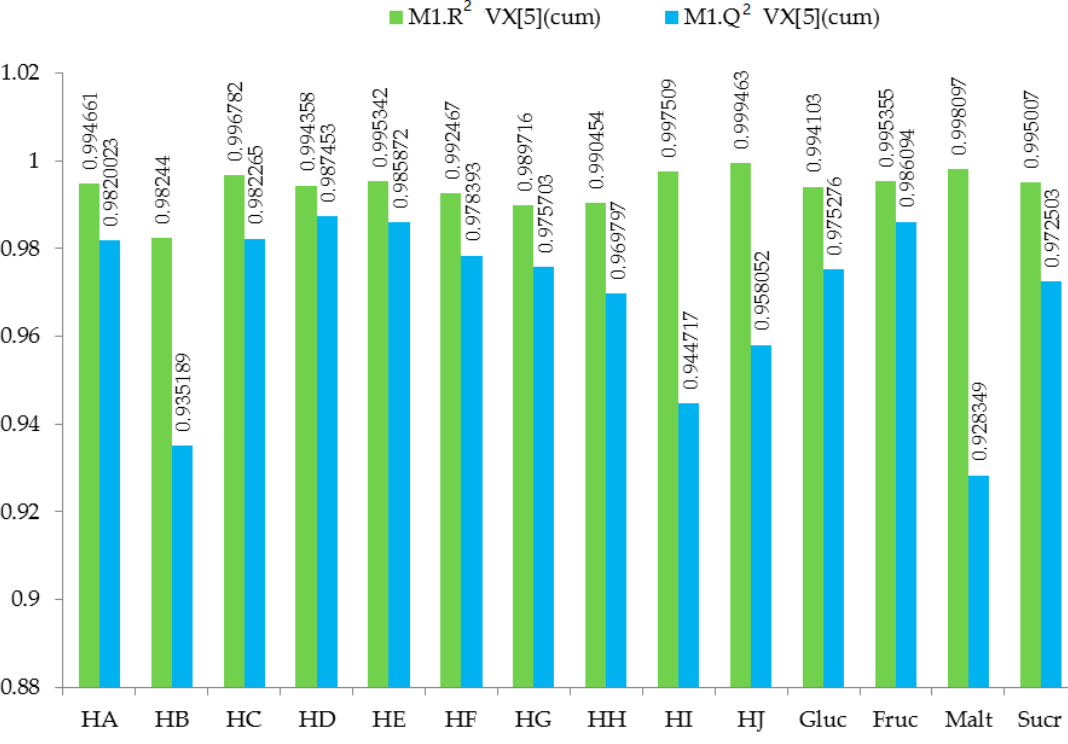
Figure 7. Cumulative cross-validation values for R 2 and Q 2 for HA-HG and the reference sugars, using Simca 15 software.